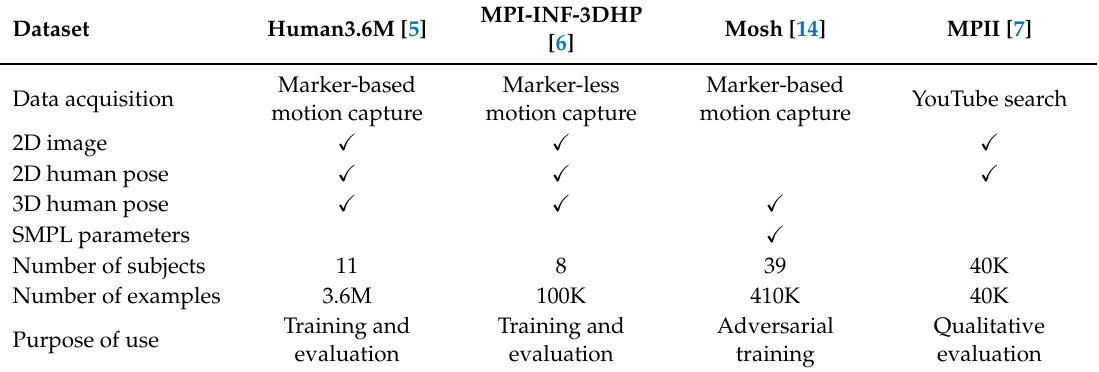
Table 2. Description of the datasets used in our